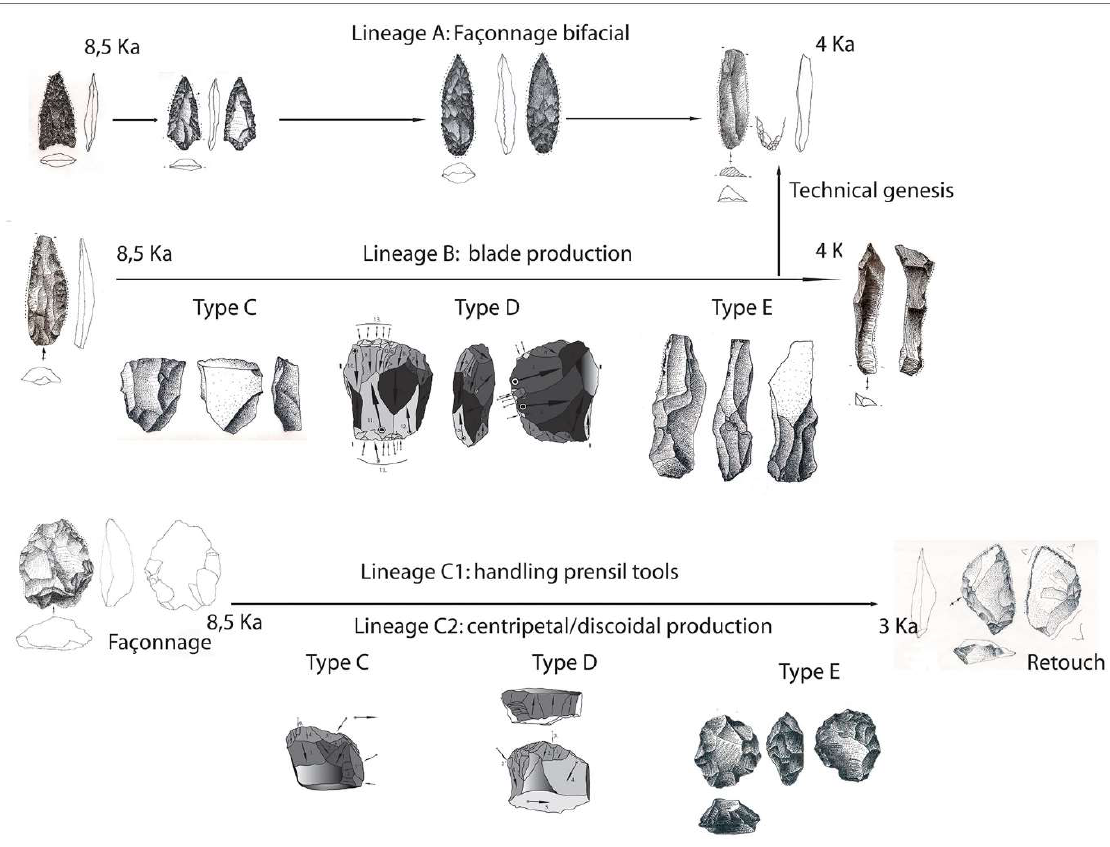
Figure 19. Examples of technical lineages in South